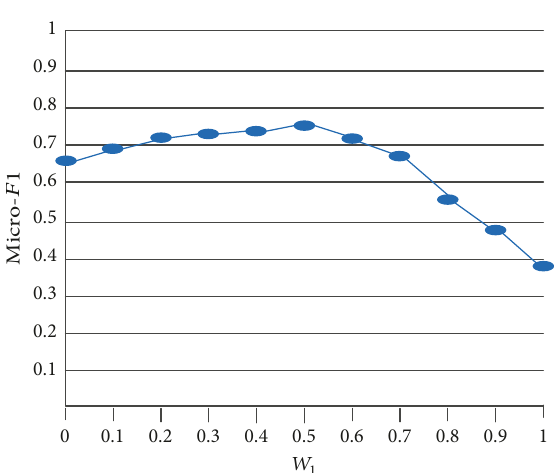
Figure 3: Comparison of Micro- 𝐹1 for each model.